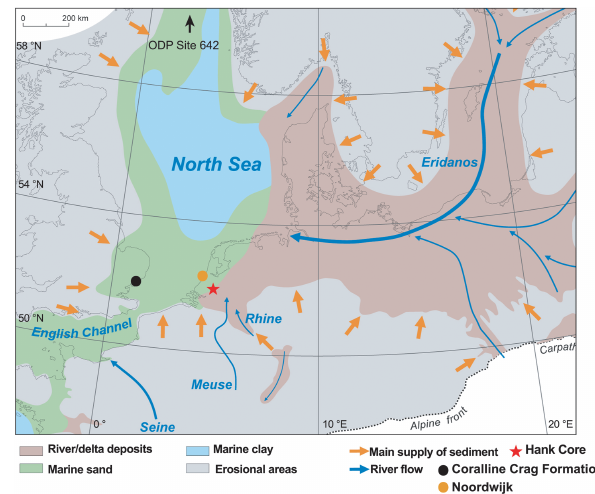
Figure 1. Pliocene palaeogeography in the North Sea basin (Gib- bard and Lewin, 2003; Knox et al., 2010). The location of the Hank borehole is represented by a red star. Major rivers and sediment in- puts are represented by blue and orange arrows, respectively. Other locations mentioned in the text are indicated. Figure modified from Gibbard and Lewin